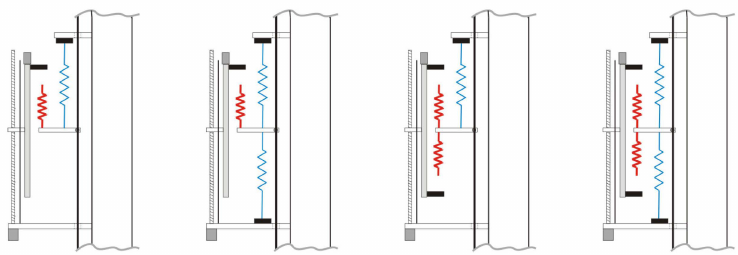
Figure 23. 4 Design sets for bi-directional stiffness mechanism. Low stiffness spring constant = 80 N/mm. High stiffness spring constant = 400 N/mm. Offset = 5 mm. ( a ) No Springs; ( b ) Low Stiffness; ( c ) High Stiffness; ( d ) (Low + High) Stiffness Springs.